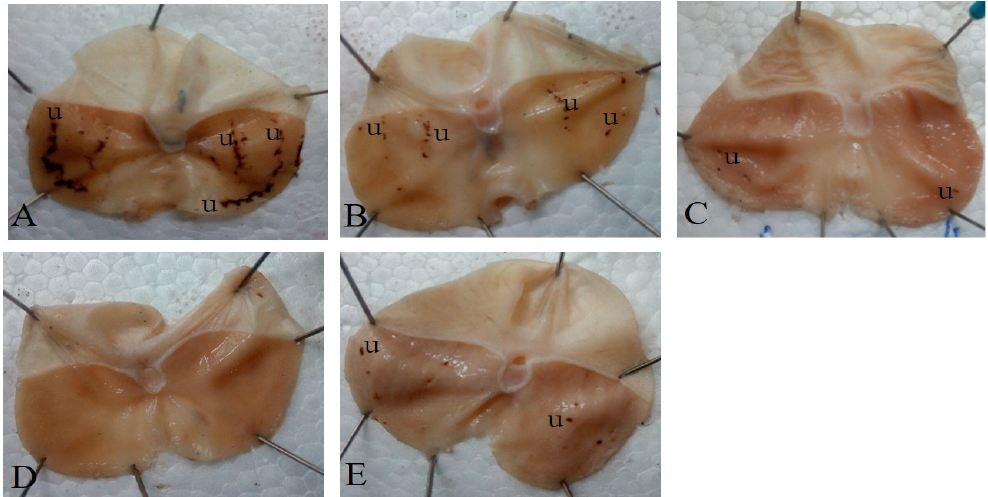
Figure 2. Gross morphology of stomach of indomethacin-induced gastric ulcer in rats Legend: “U” = ulcer lesion, A = Distilled water 5 ml/kg, B = Misoprostol 50 µg/kg, C =MFCS 12.5 mg/kg, D = MFCS 25 mg/kg, E = MFCS 50 mg/ kg